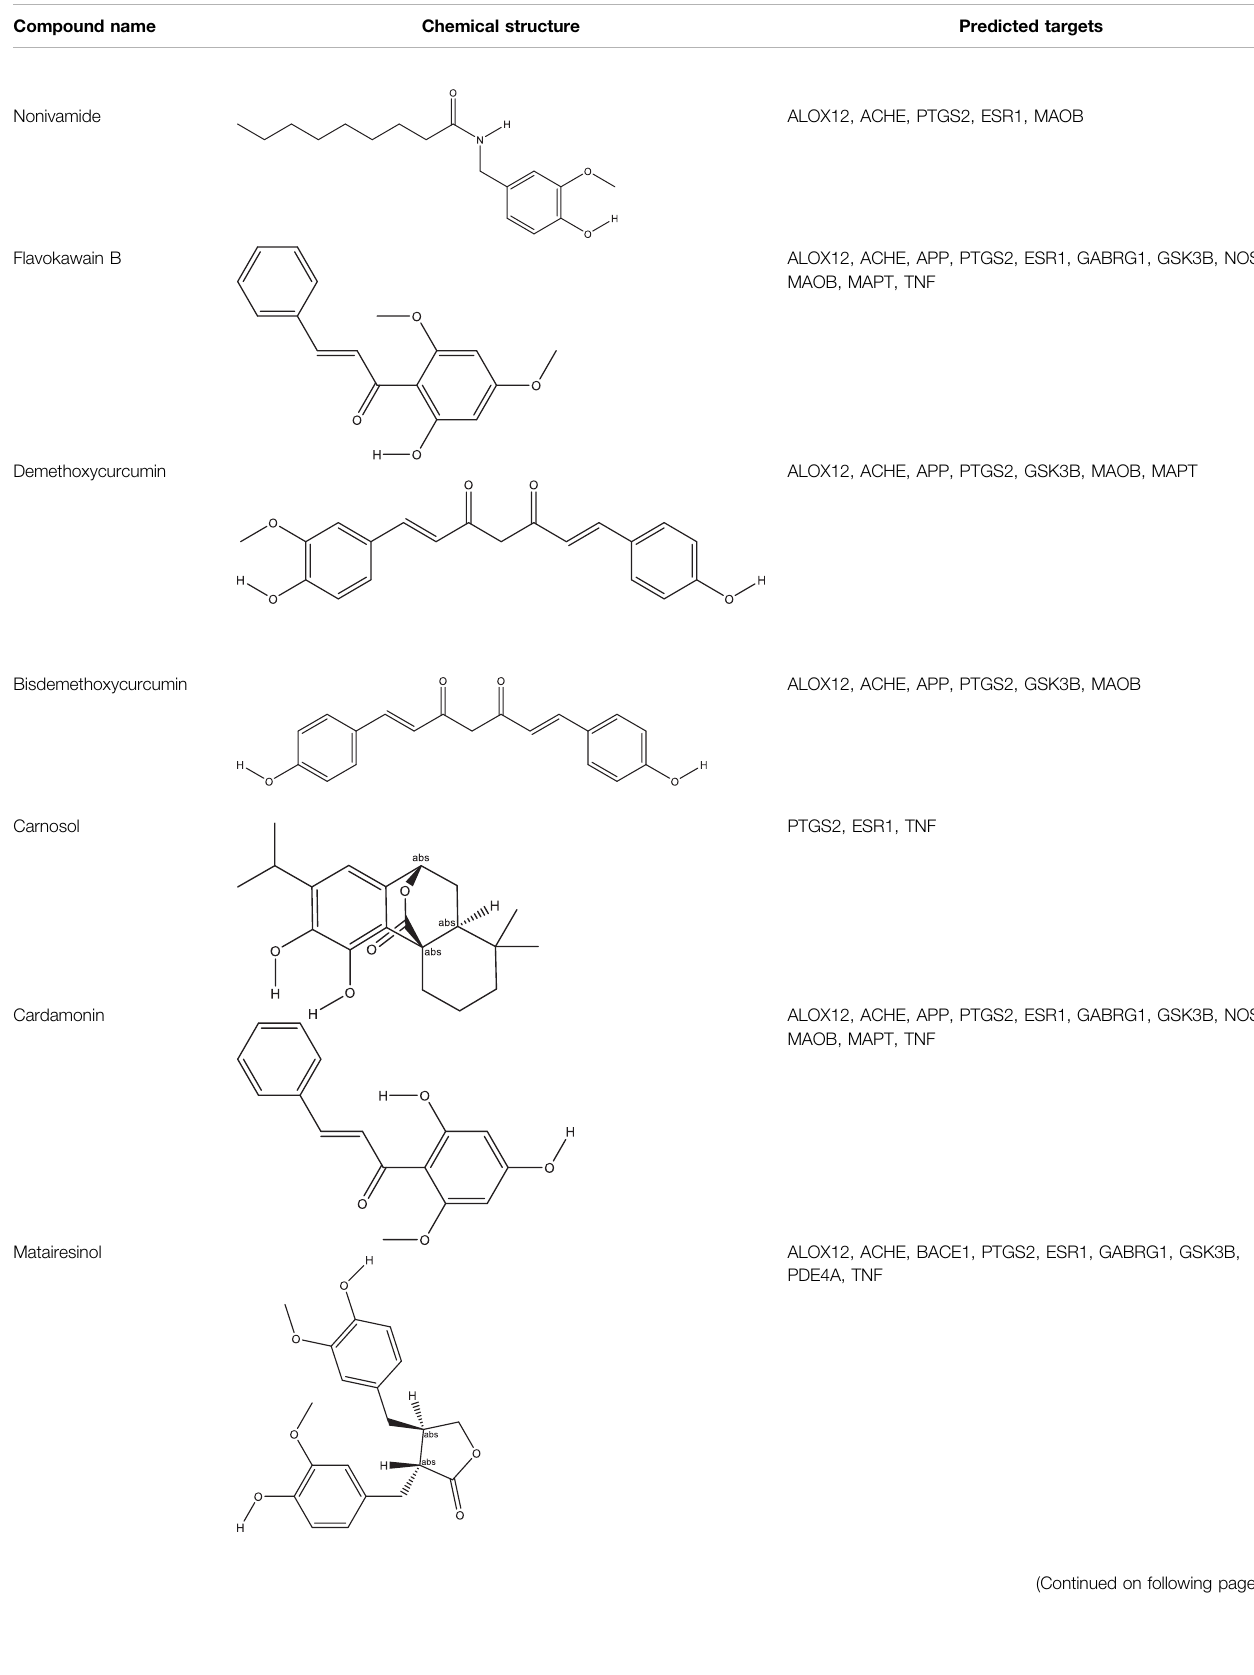
TABLE 2 | ( Continued ) The 16 typical examples of multi-target